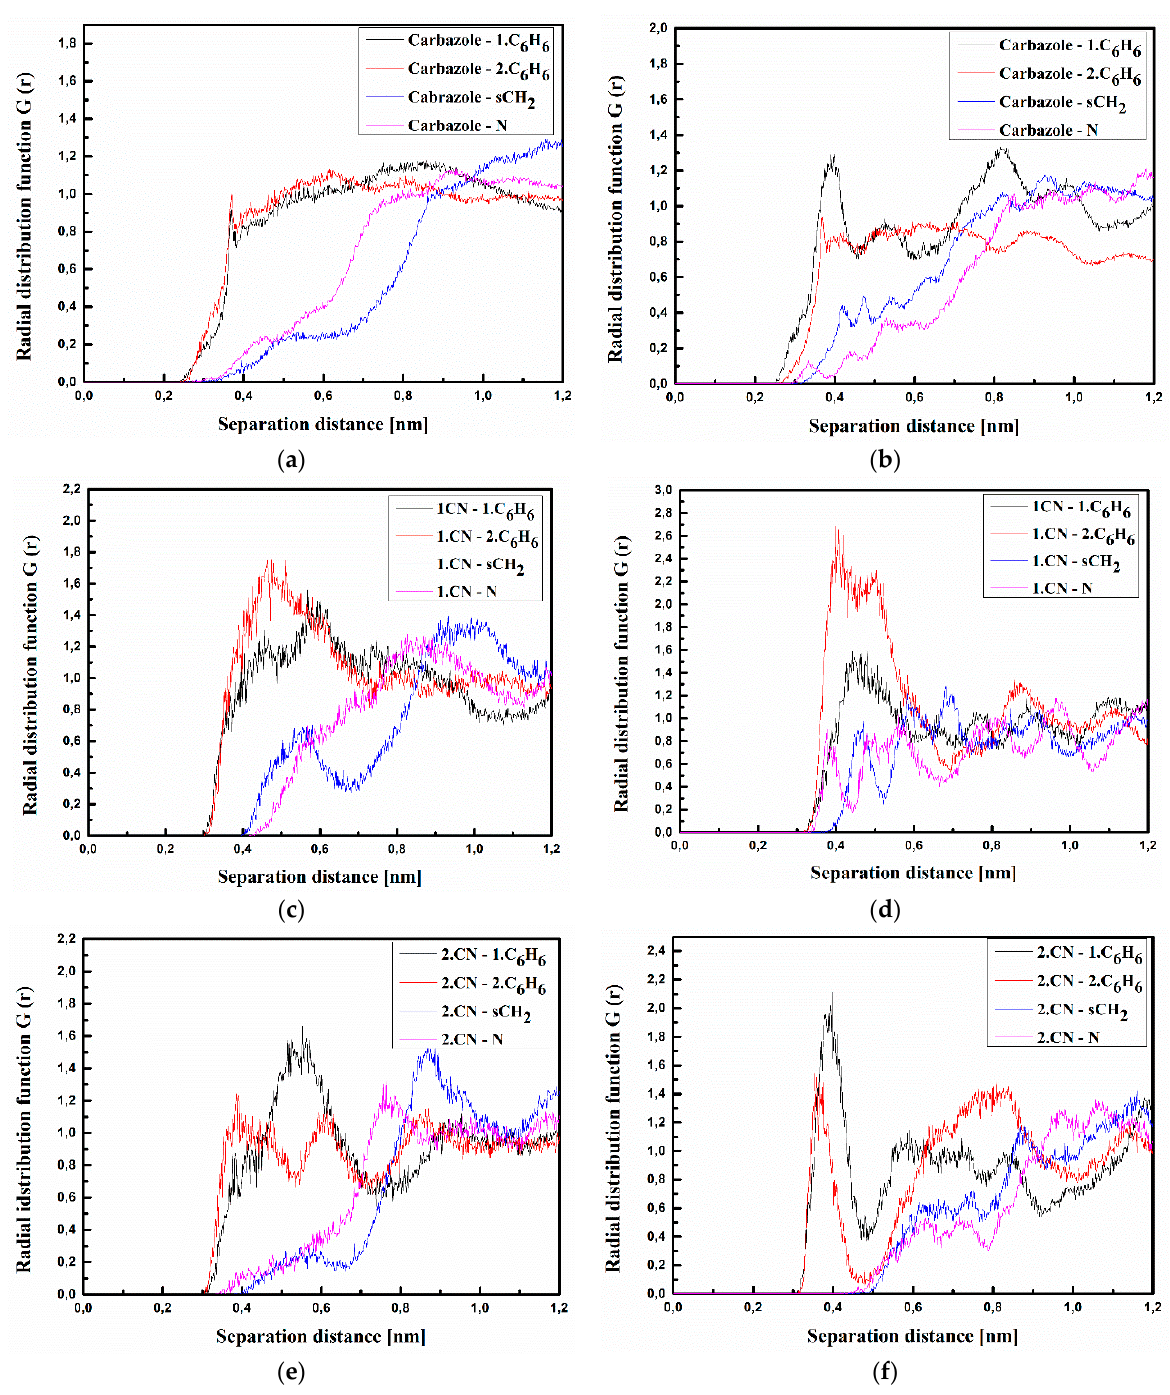
Figure 5. Partial RDFs calculated for distances between the center of mass of different moieties of the C molecule and different subunits of PVK at T = 500 K ( a , c , e ) and T = 300 K ( b , d , f ) for the bulk system. The RDFs are presented for carbazole group of C molecule and different subunits of PVK mer ( a , b ); for cyanovinyl CN1 at the side of the molecule C and different subunits of PVK mer ( c , d ); and cyanovinyl CN2 at the back of the molecule C and different subunits of PVK mer ( e , f ). Analyzing the data presented in Figure 3, one can see that the A molecule is located close to the carbazole group of the PVK polymer chain. The closest distance between all defined groups of molecule A (both CN groups and Me group) is equal to 0.4 nm for the system in the liquid phase (at 500 K) (see Figure 3a,c,e). The distance between Me